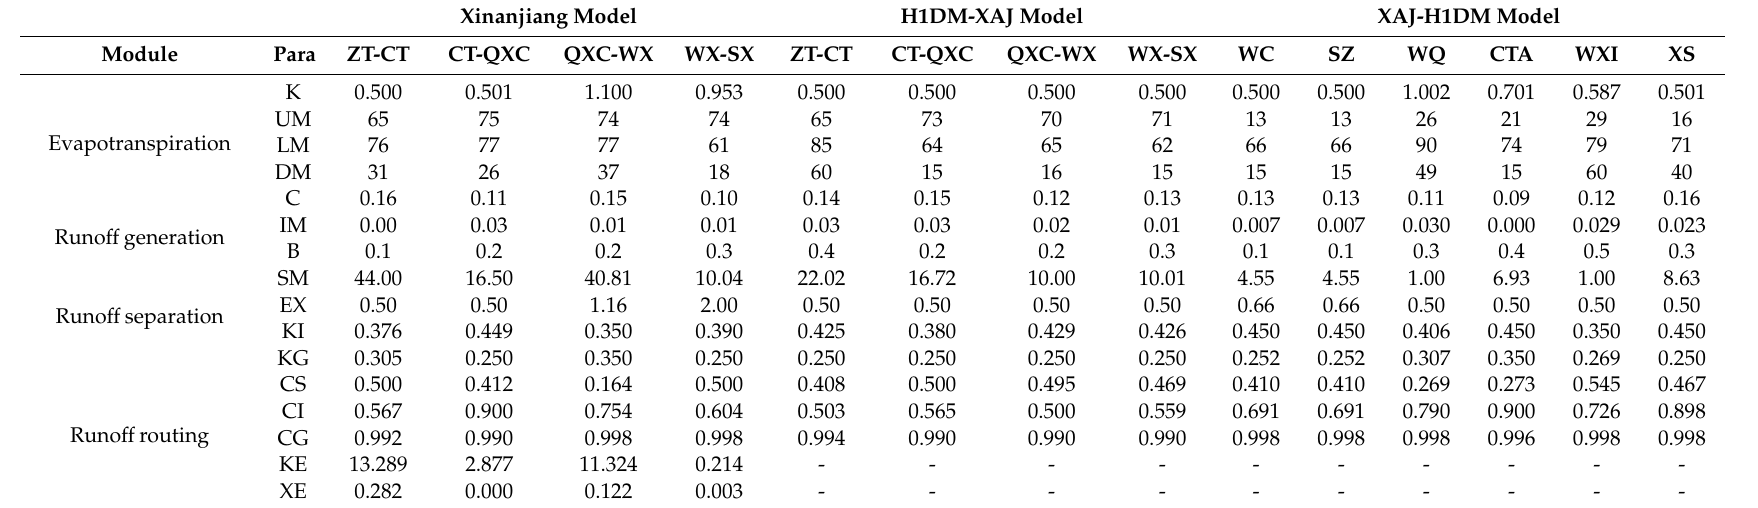
Table 2. List of parameters of the models and the calibrated values for the study